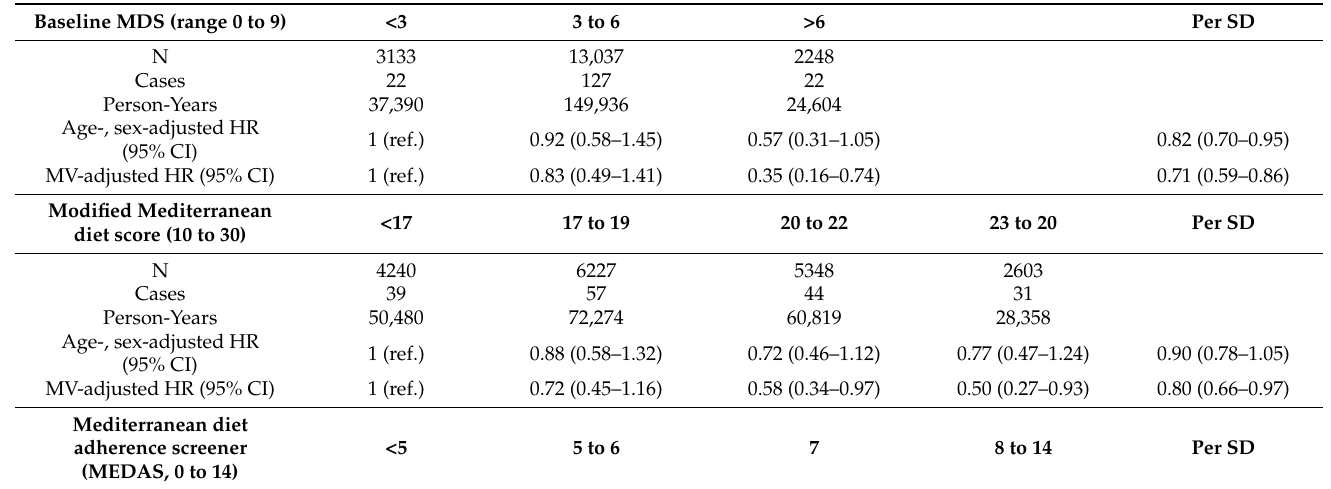
Table 2. Hazard ratios (95% confidence intervals) of CVD according to different MedDiet